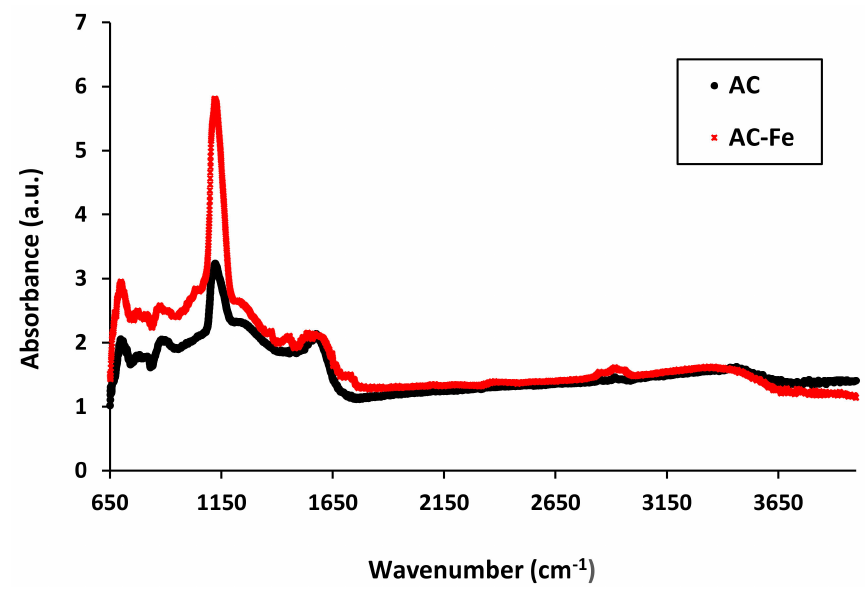
Figure 4. FTIR spectra of AC and